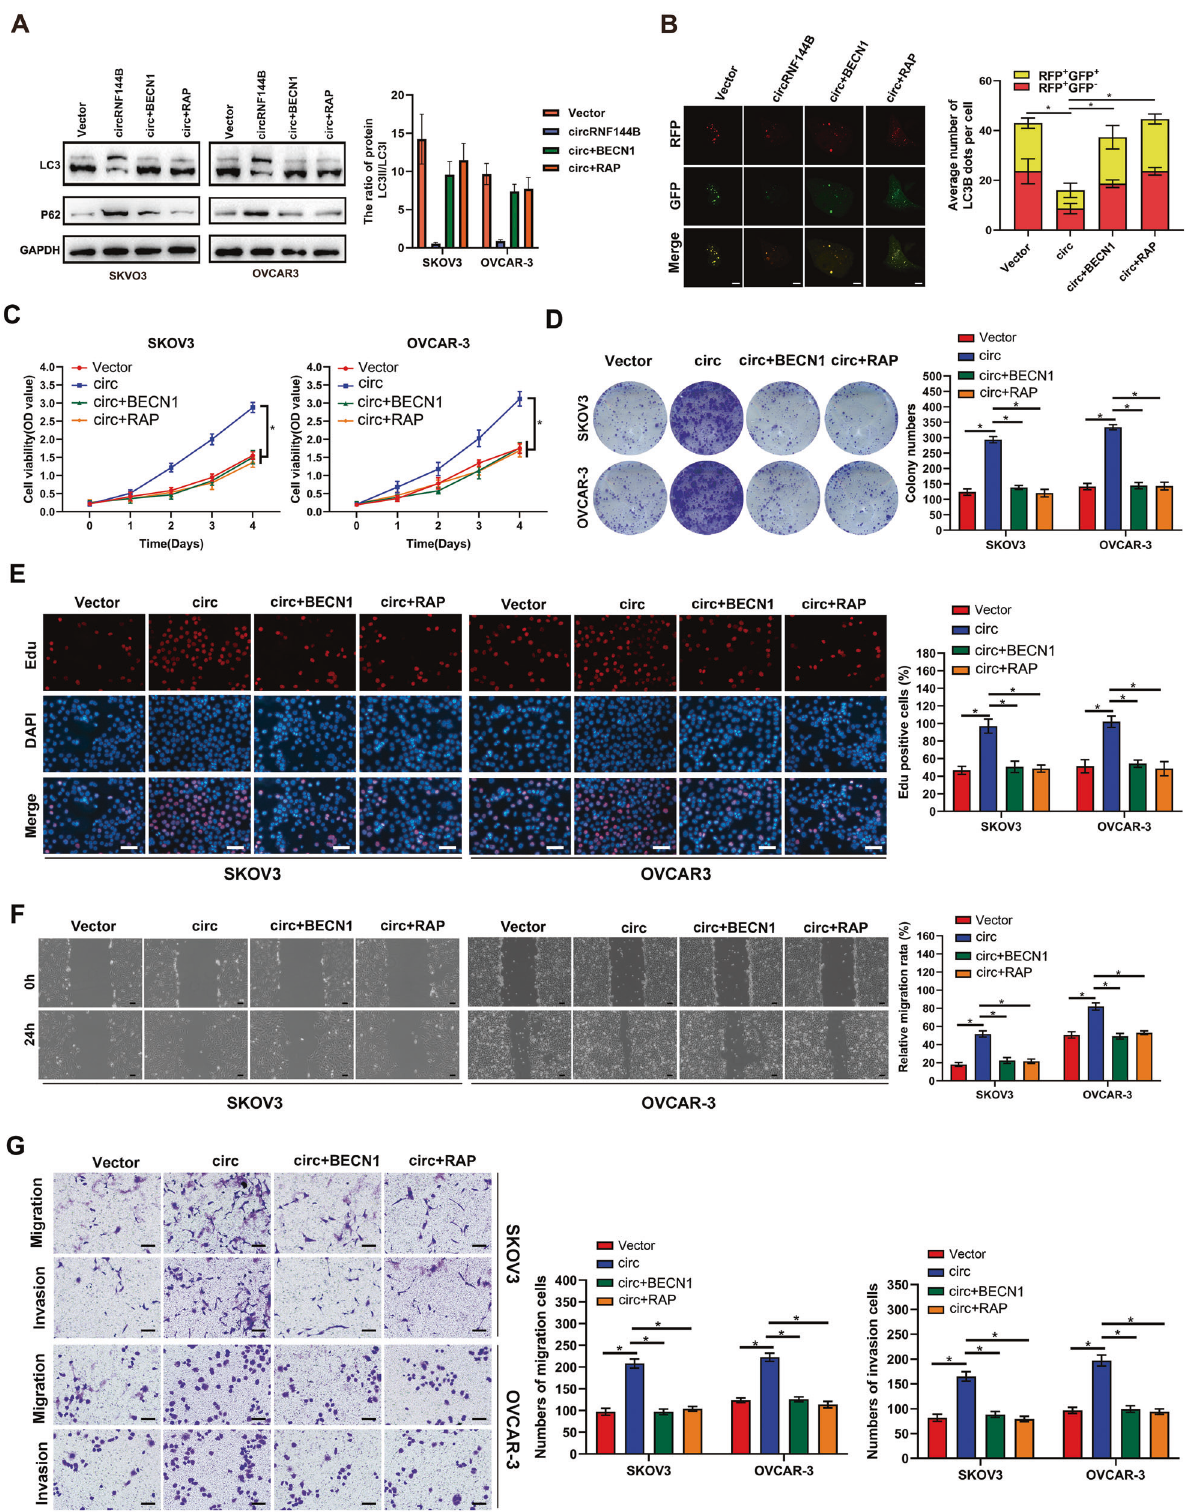
Fig. 8 Rescued autophagy in OC cells reversed the effects of circRNF144B. OC cells were divided into four groups according to treatment factors: negative control (NC), circRNF144B-overepression, circRNF144B-overexpression + Beclin-1-overexpression and circRNF144B- overexpression + rapamycin (RAP) treatment. A Western blotting was used to detect LC3 and P62 in each group of cells. B Confocal microscopy was used to detect the number of autophagosomes and autophagolysosomes in each cell group. Scale bar, 25 μ m. C CCK-8 was used to detect the cell viability in each group cells. D Colony formation assay was used to detect colony formation in each group of cells. E EDU positive rate in each group was detected. Scale bar, 100 μ m F Wound healing assay was used to detect cell migration in each group cells. Scale bar, 50 μ m. G Transwell assay was used to detect the invasion in each group of cells. Scale bar, 50 μ m. *, P < 0.05.